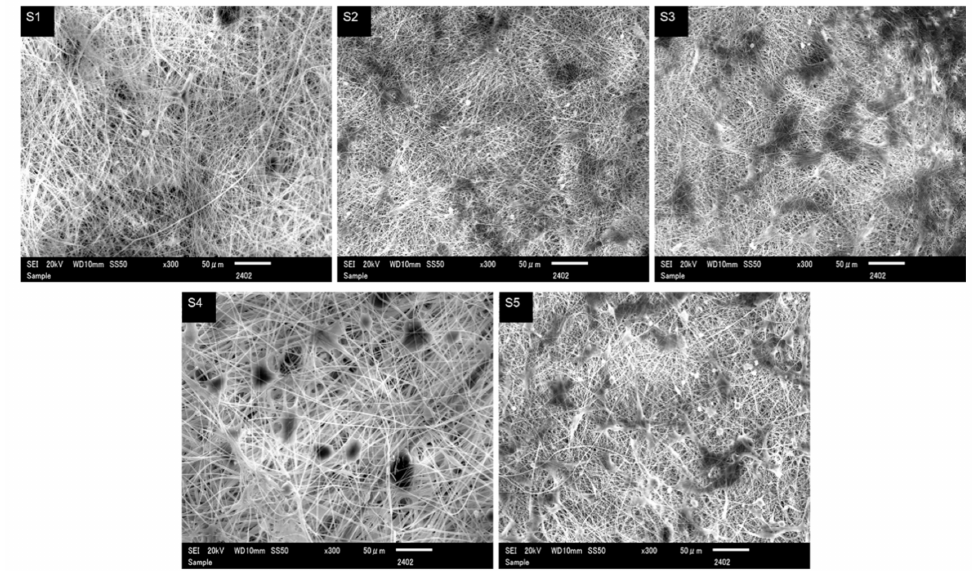
Figure 6. Cell attachment of L929 cells cultured for 7days in presence of neat ( S1 ) and DLF loaded PAN nanofibers ( S2 – S5